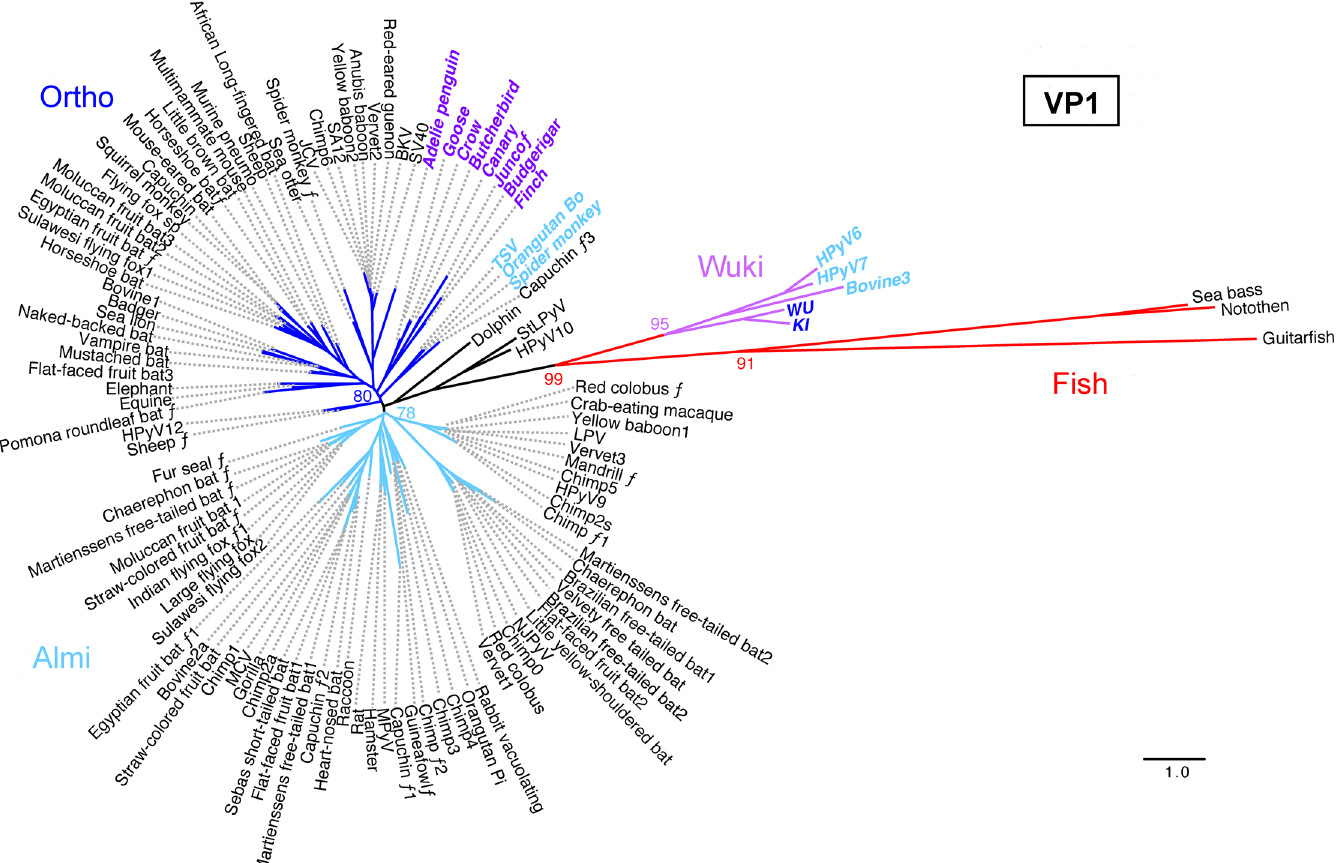
Fig 4. Midpoint-rooted phylogenetic tree for polyomavirus VP1 protein sequences. Species with different clade affiliations in LT analyses (Fig 3) are indicated in colored bold oblique text. The script ƒ character indicates fragmentary (sub-genomic) sequences. Percent bootstrap values for selected nodes are indicated. A FigTree file containing detailed bootstrap values is provided as S3 File. Scale bar shows one substitution per site.